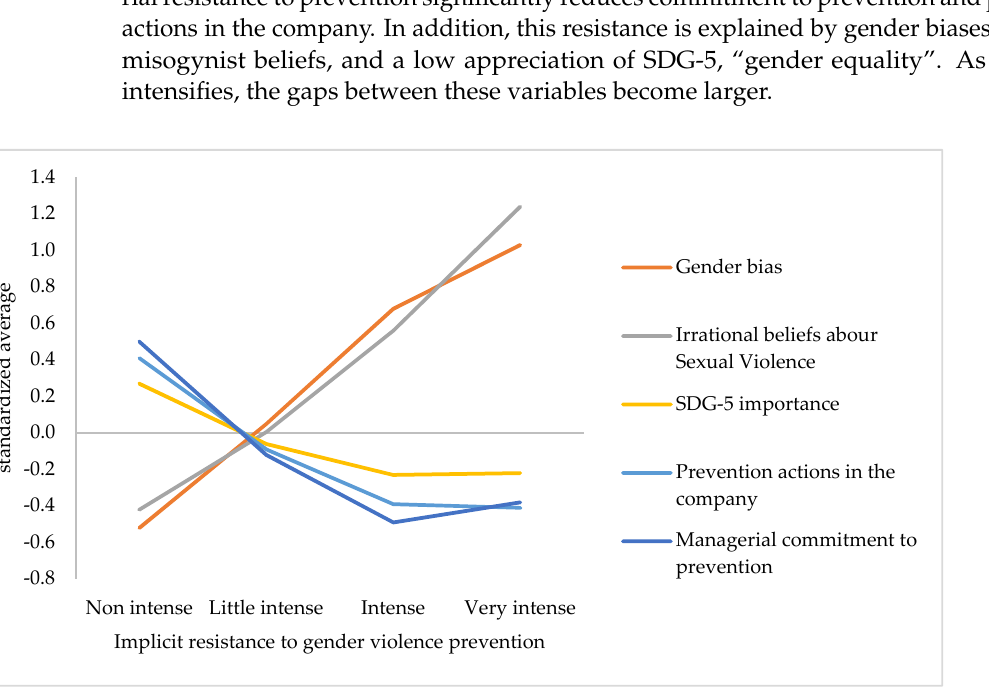
Figure 3. Managerial profile towards the prevention of violence against women according to the level of implicit resistance. Note: Standardized mean difference. Gender biases (F = 46.251, p < 0.001), irrational beliefs about sexual violence (F = 37.894, p < 0.001), SDG-5 importance (F = 7.471, p < 0.001), personal commitment towards prevention (F = 27.732, p < 0.001), and prevention actions in the company (F = 18.903, p <